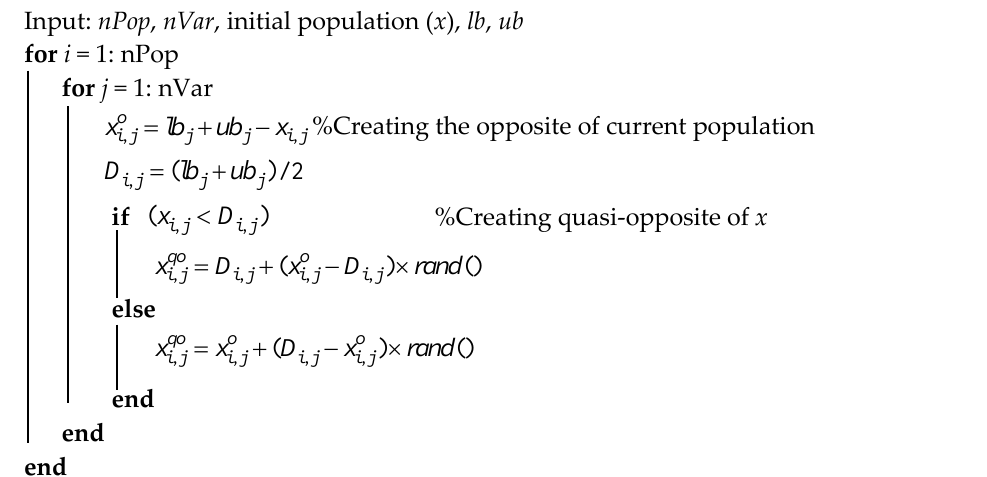
Algorithm 2: Pseudocode of quasi-oppositional-based learning